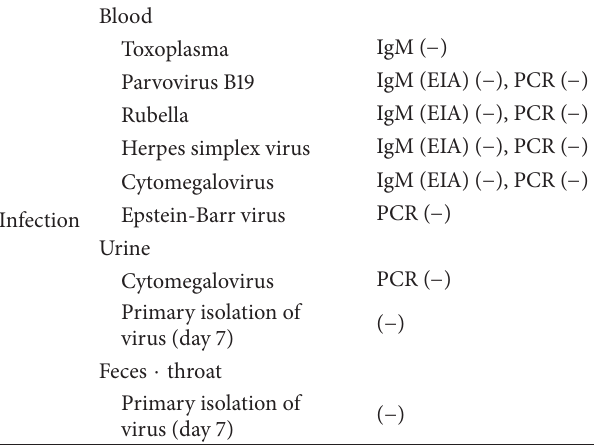
Table 3: Laboratory findings about antecedent